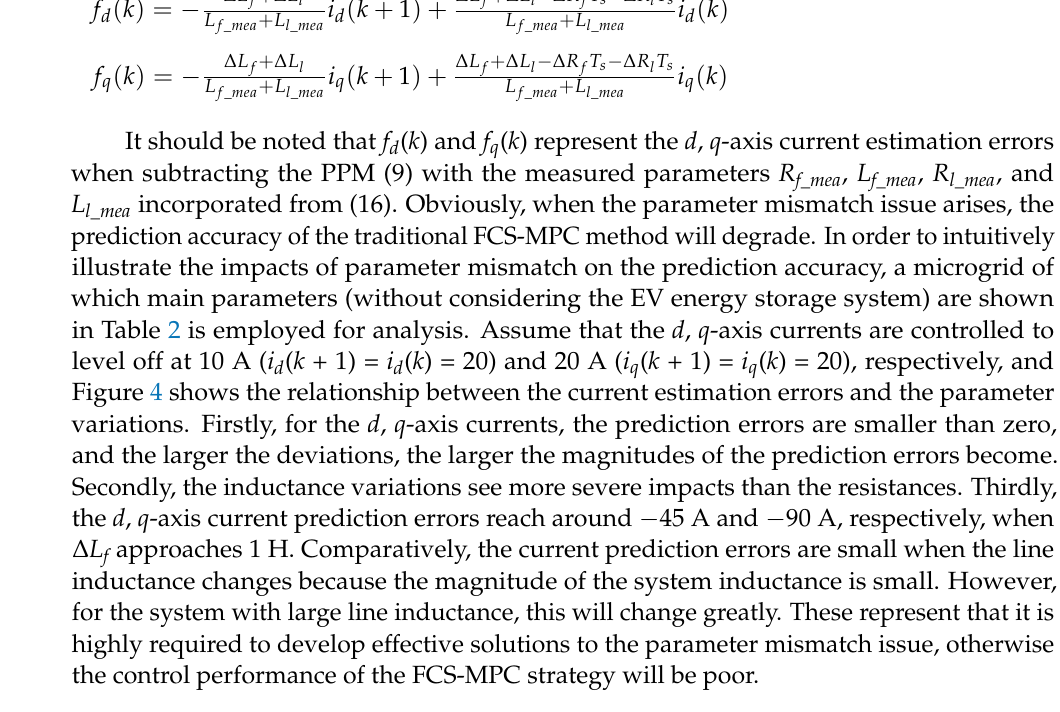
Table 2. Main parameters of the